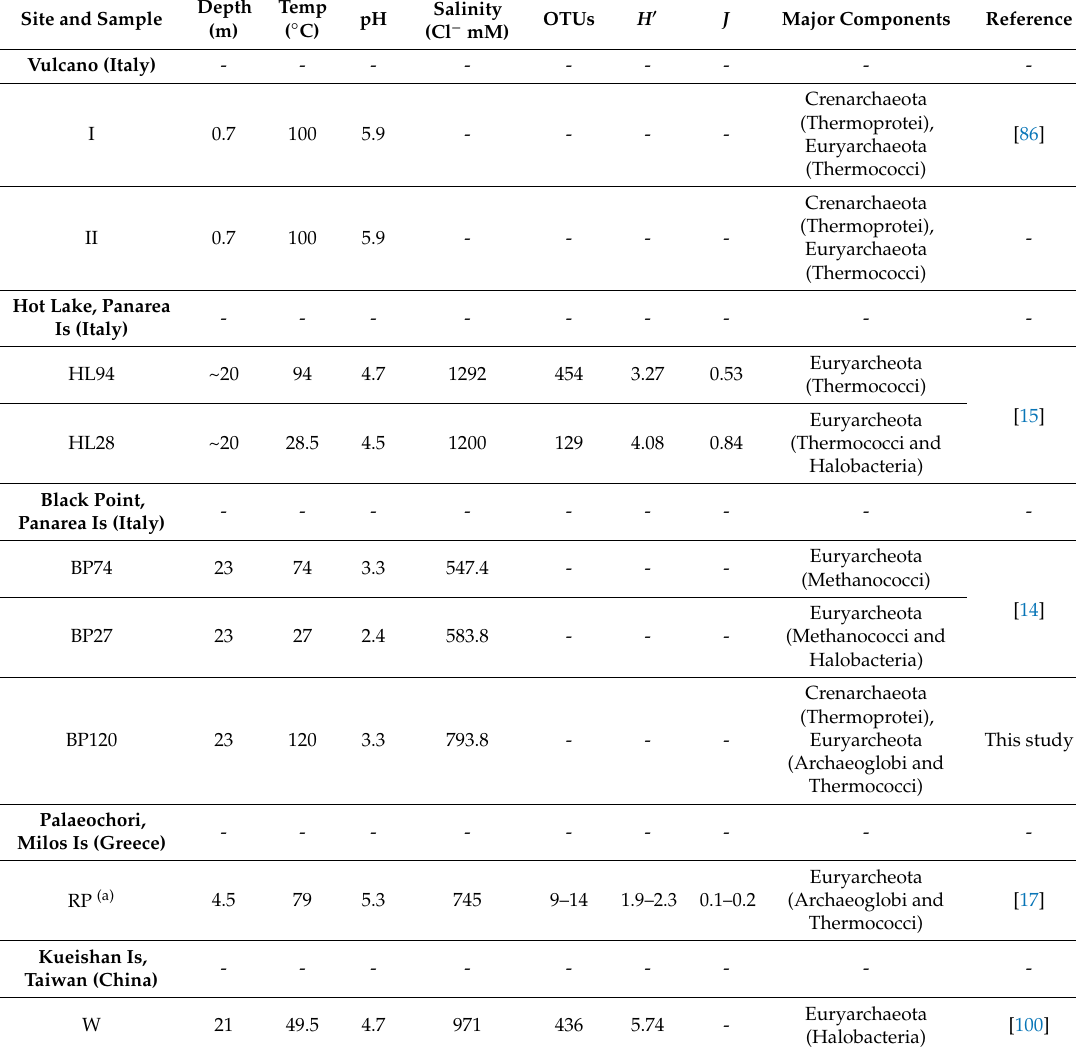
Table 7. Archaeal major components retrieved by next generation sequencing at Vulcano, Black Point, and Hot Lake sites in comparison with those from other shallow